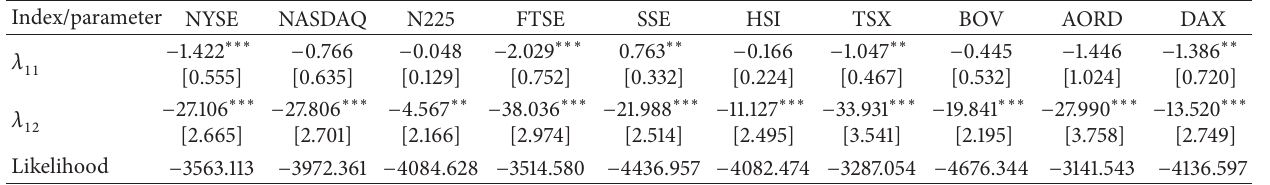
Table 9: Results of TVRAS-GARCH-M model (MIN).